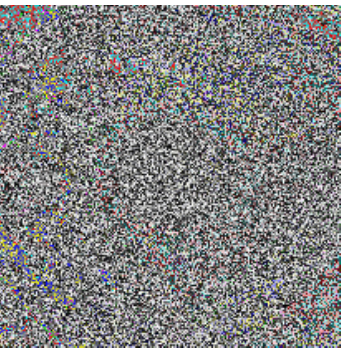
Figure 8. Ciphering process without a permutation process causes the circular structure of the iris to be